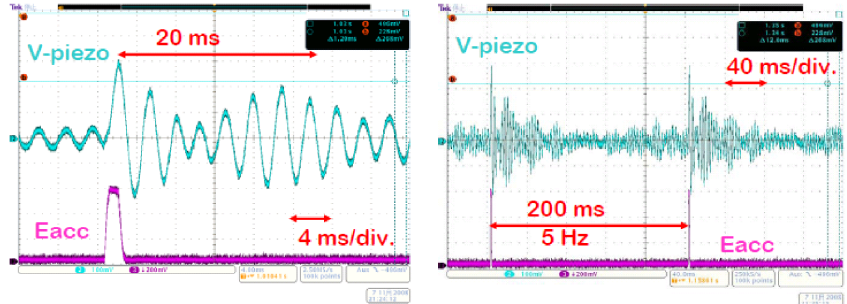
FIG. 16. (Color) Observation of mechanical vibrations during pulsed operation at 5 Hz and 28 : 2 MV = m in C/#2 cavity. The light blue line is the output voltage from the piezo sensor. The purple line is an acceleration gradient operated with a pulsed mode. The left image has a shorter time range with 4 ms per division, and the right has a longer time range with 40 ms per